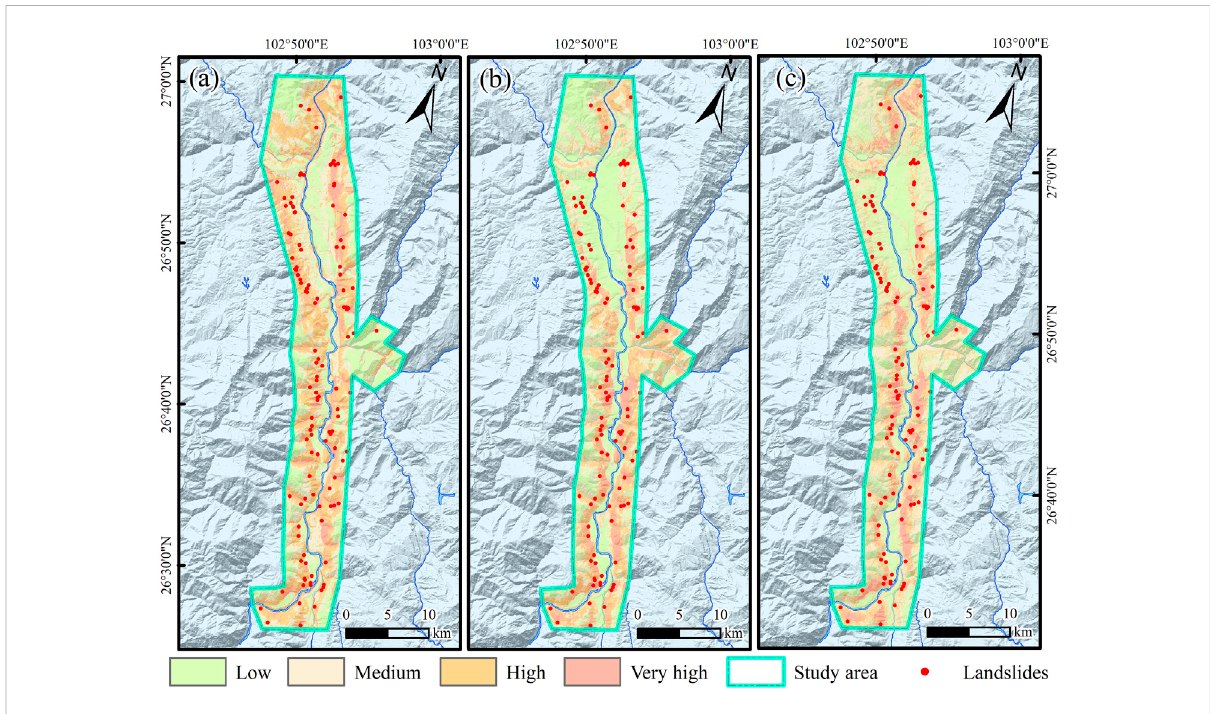
FIGURE 5 Landslide susceptibility mapping results. [ (A) BPNN; (B) FR-BPNN; (C)